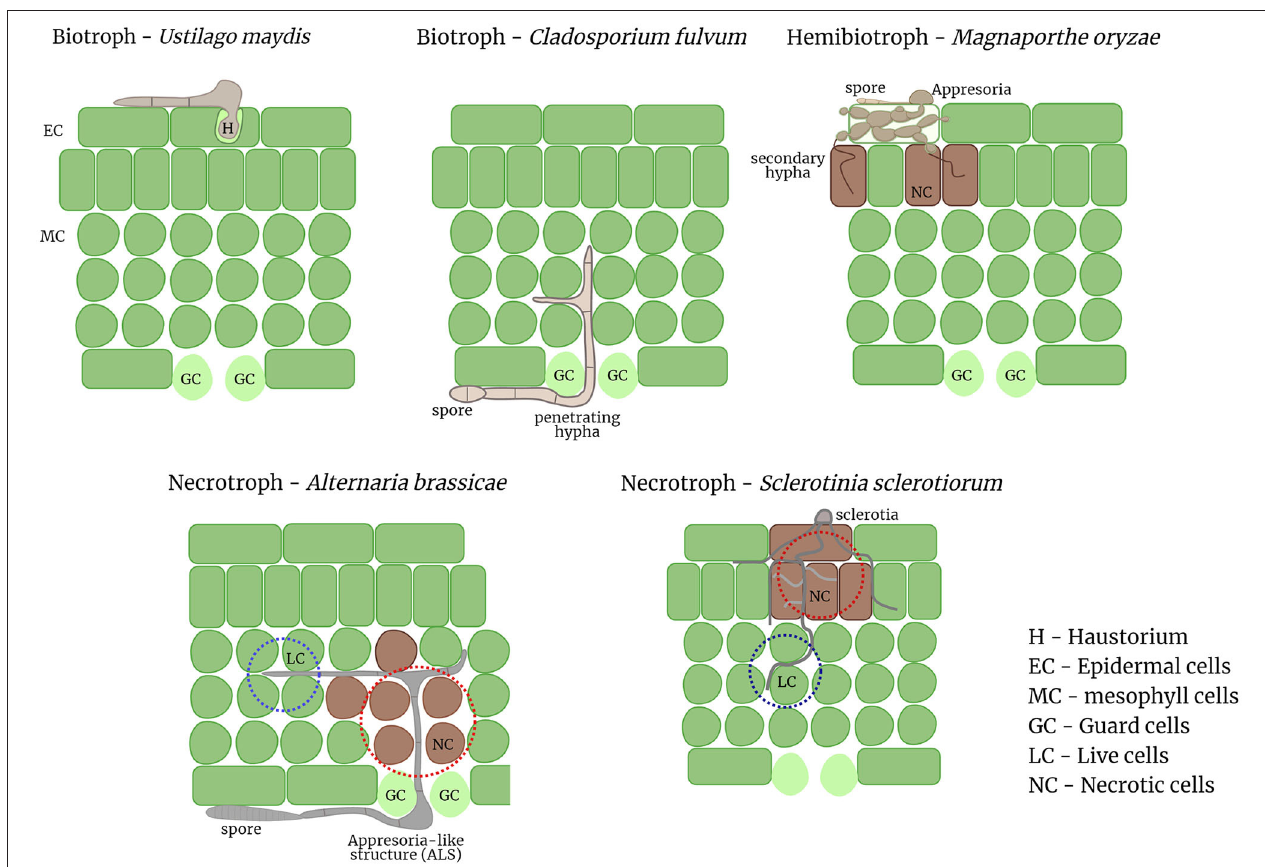
FIGURE 1 | Pathogenic invasion strategies of diverse pathogens from different trophic lifestyles. Biotrophic pathogens like U. maydis form a haustorium inside a host cell to acquire nutrients from the host while biotrophs like C. fulvum grow extracellularly between the host cells. Hemibiotrophs like M. oryzae form penetration